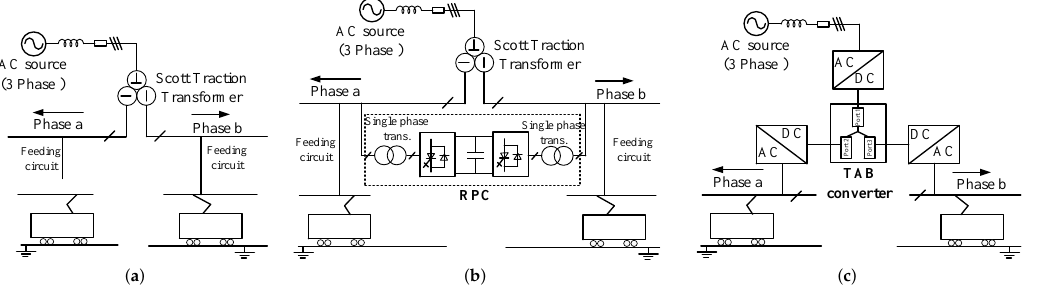
Proposed future concept for shinkansen power supply using the TAB